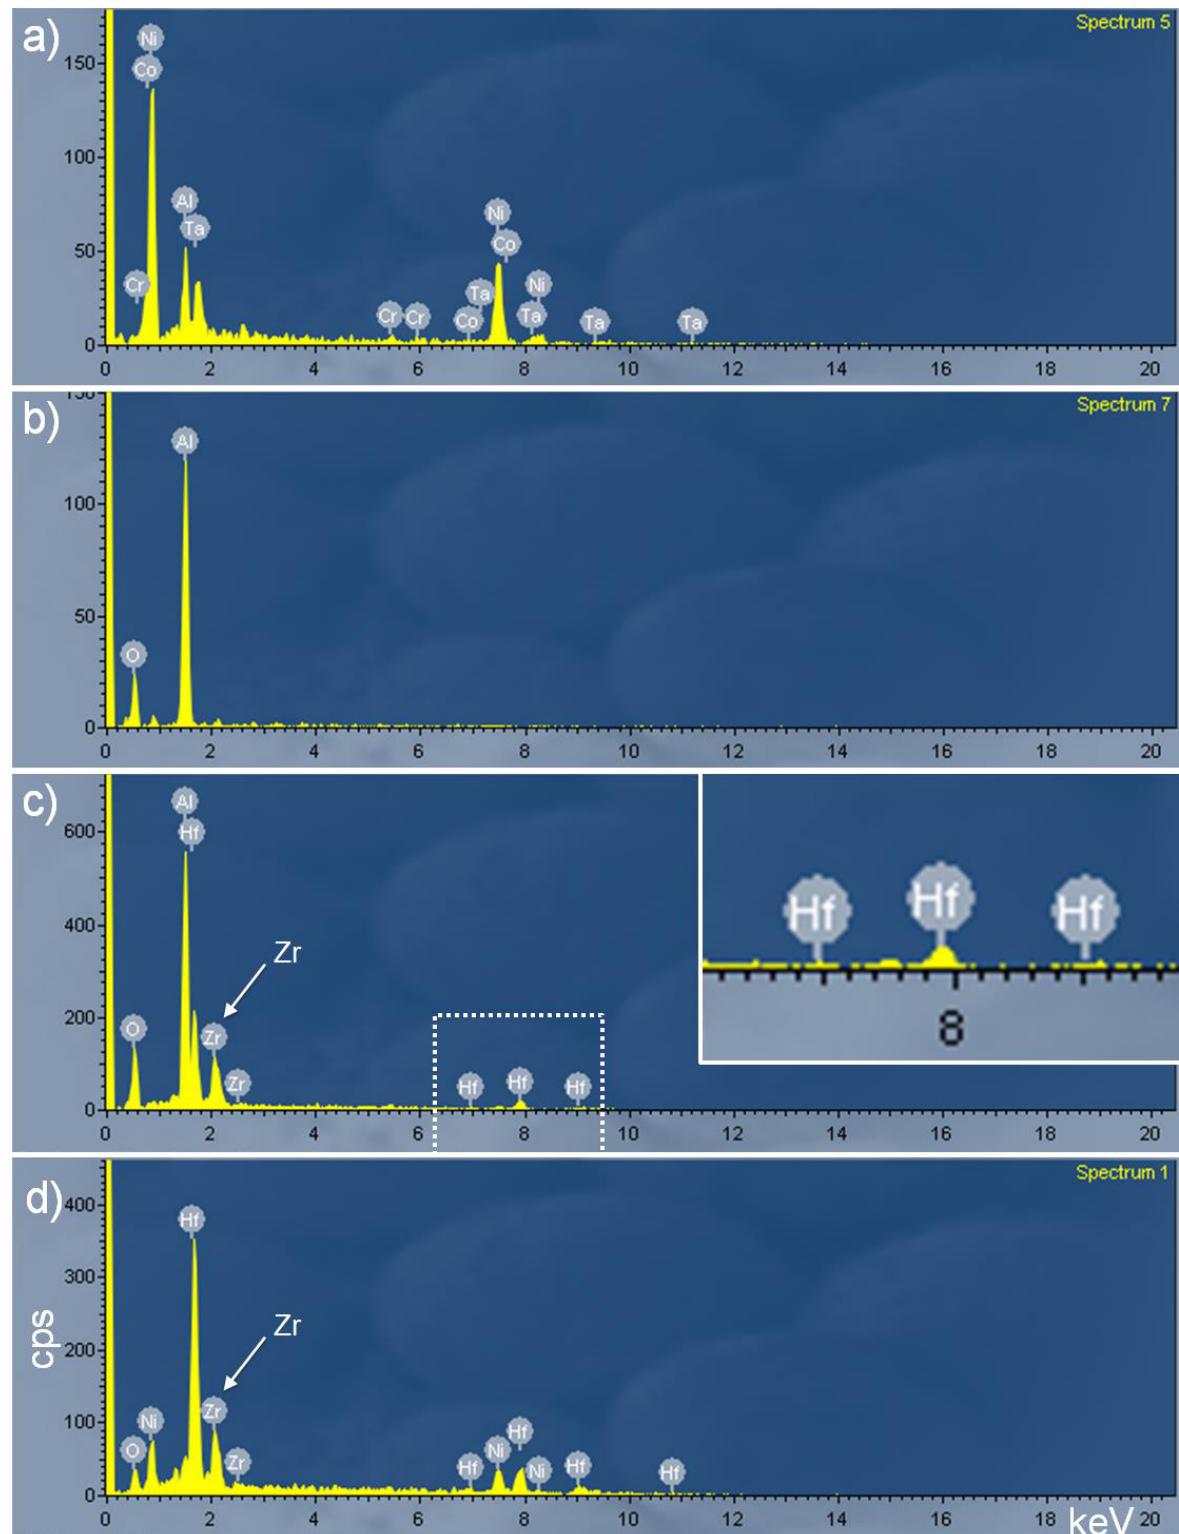
Figure 3. Representative SEM-EDX spectra acquired on a reference base material or metallic particles ( a ), aluminium oxide ( b ), a local area in Figure 2d ( c ), and the tiny particle in Figure 2f ( d ).